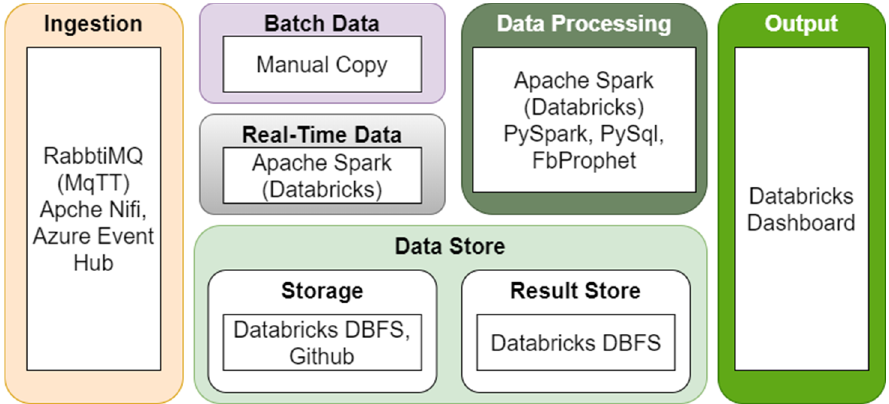
Figure 7. Analytics components using Azure Databricks tools.